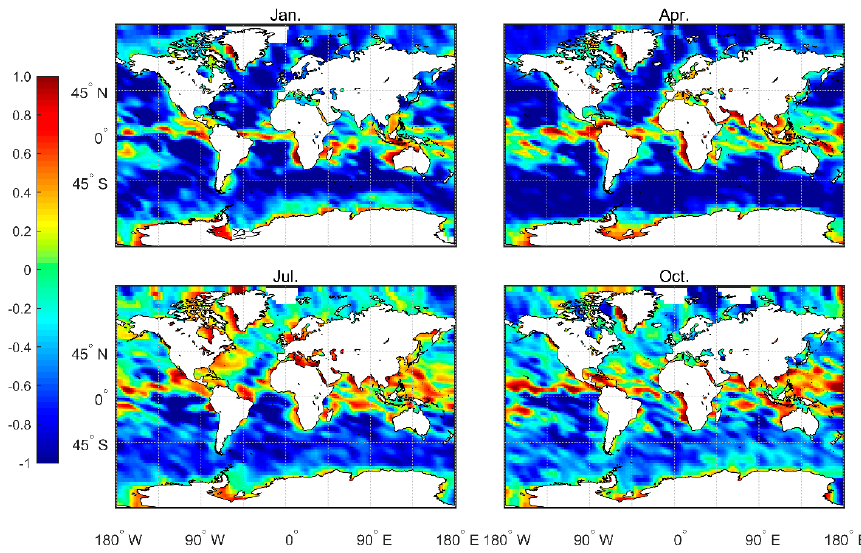
Figure 9. The difference between average MBLH based on 2007–2011 CDAAC echprf and atmprf products.